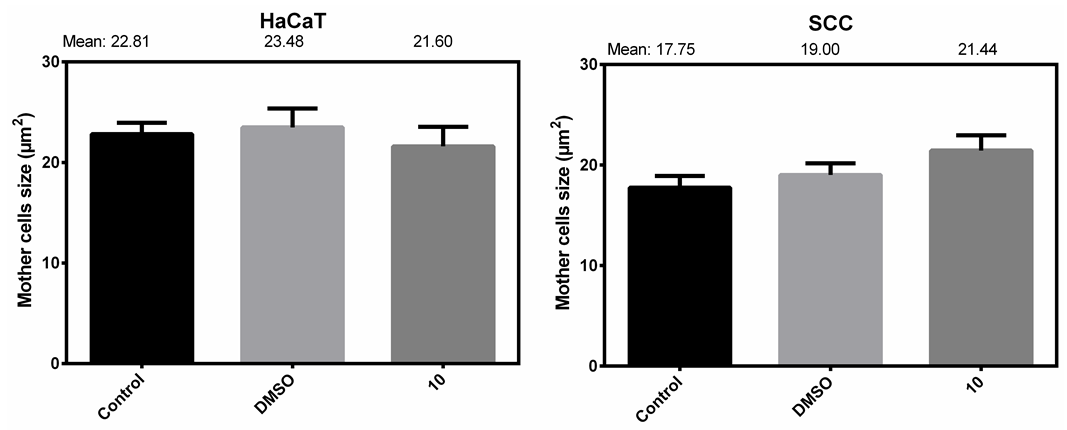
Figure 4. E ff ect of DMSO and compound 10 (17.0 µ M) on the mother cell sizes of HaCaT and SCC cells. Figure 4 . Effect of DMSO and compound 10 (17.0 µM) on the mother cell sizes of HaCaT and SCC Generation cells.